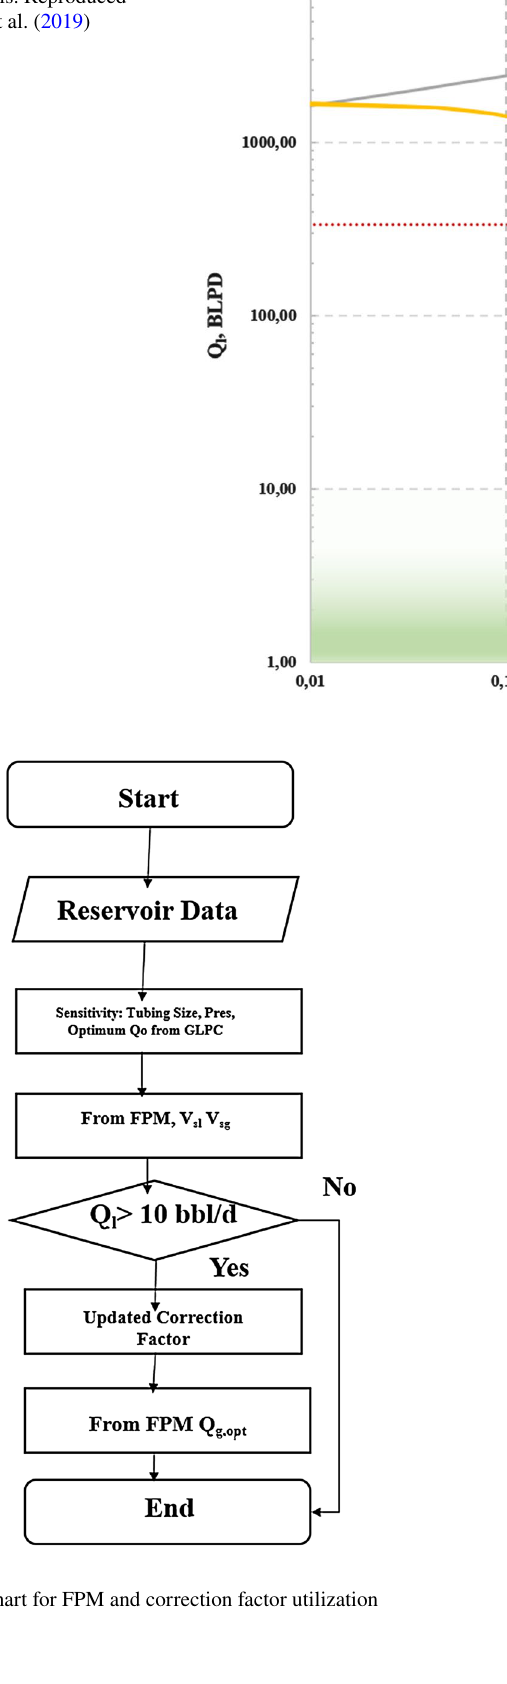
Fig. 3 Flow pattern map for gas-lifted wells. Reproduced from Daton et al. (2019)